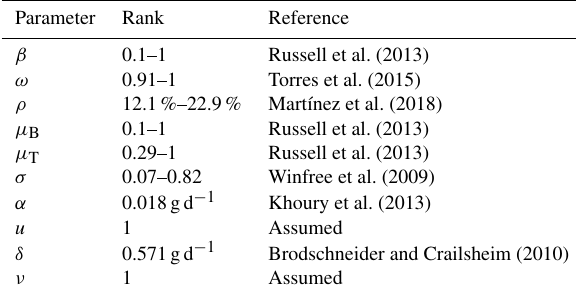
Table 4. Parameter values included in the model (Eq. 5).